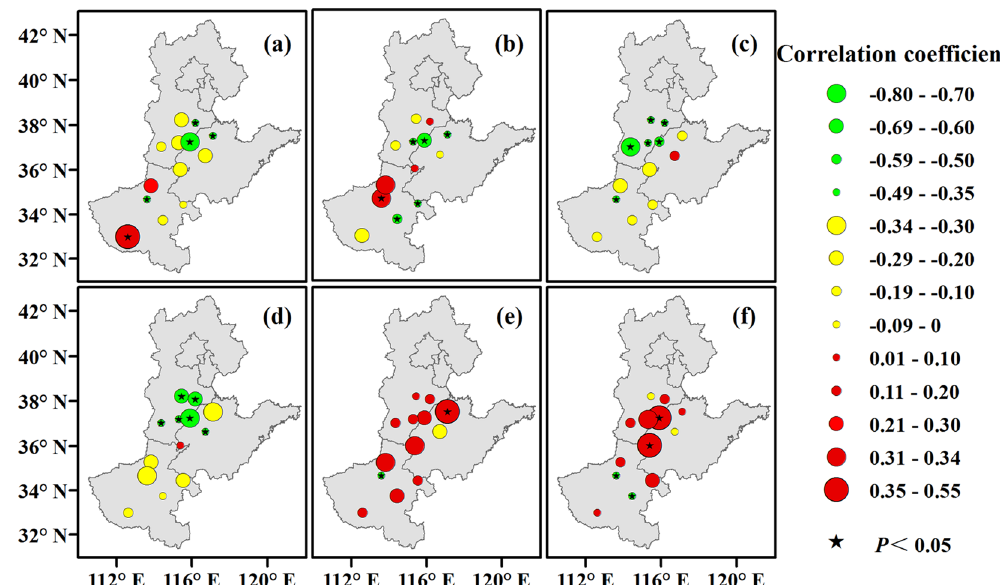
Figure 5. Correlation between Tmean and the lengths of the sowing-emergence ( a ), emergence-squaring ( b ), squaring-flowering ( c ), flowering-boll opening ( d ), and boll opening-harvest ( e ) periods and the whole growing period ( f ) of cotton across the North China Plain from 1981 to 2012. Green, yellow, and red circles represent the correlation coefficient. Black pentagrams represent a significance level of 0.05. Maps were generated using ArcGIS 10.1 (ESRI Inc, Redlands, CA, USA,